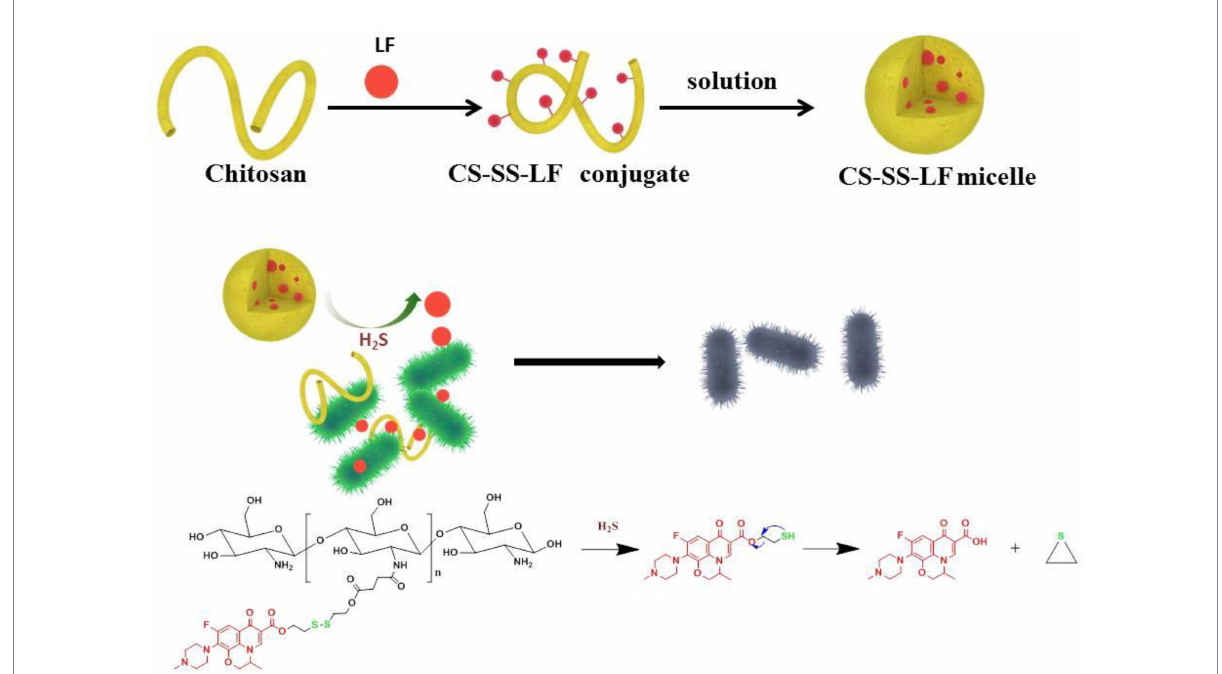
FIGURE 1 Diagram illustrating the antibacterial properties of CS-SS-LF micelles. Upon Salmonella infection, H 2 S actuates the cleavage of redox-sensitive triggers, resulting in the disintegration of micelle assemblies and release of intact antibacterial LF drug in active